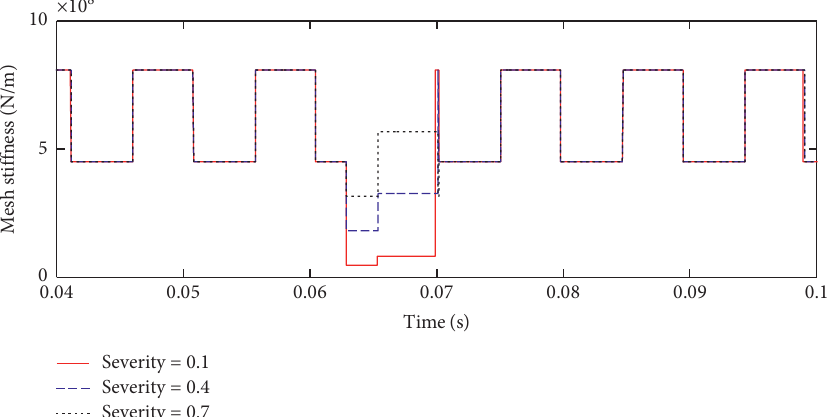
Figure 27: Meshing stiffness in different fault